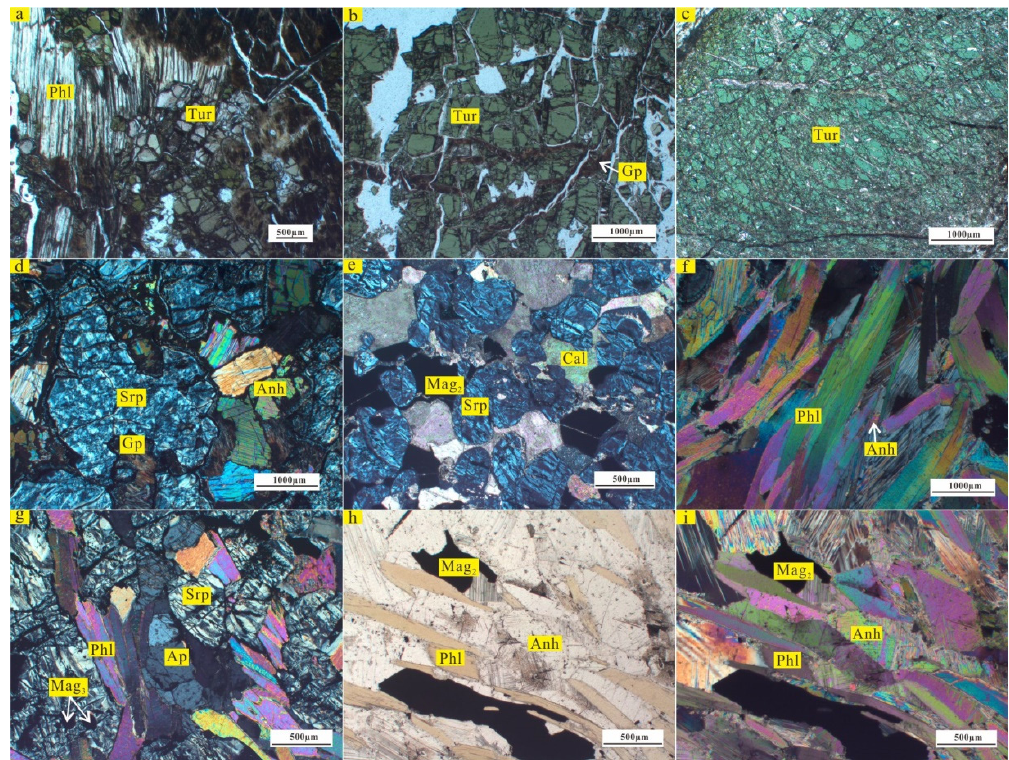
Figure 5. The mineral assemblages of other typical wall rocks in the Zhaoanzhuang iron deposit. ( a–c ) Tourmaline-rich rocks. ( d ) Anhydrite–serpentinite. ( e ) Calcite–serpentinite with some magnetite. ( f )